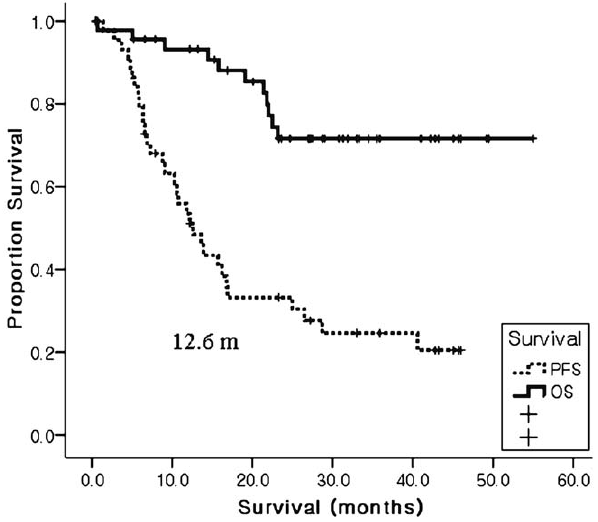
Figure 1. Kaplan-Meier estimates of median progression-free survival (PFS, dotted line) and overall survival (OS, straight line) for all patients (N=46). The median survival of PFS is 12.6 months and the median OS was not yet reached.